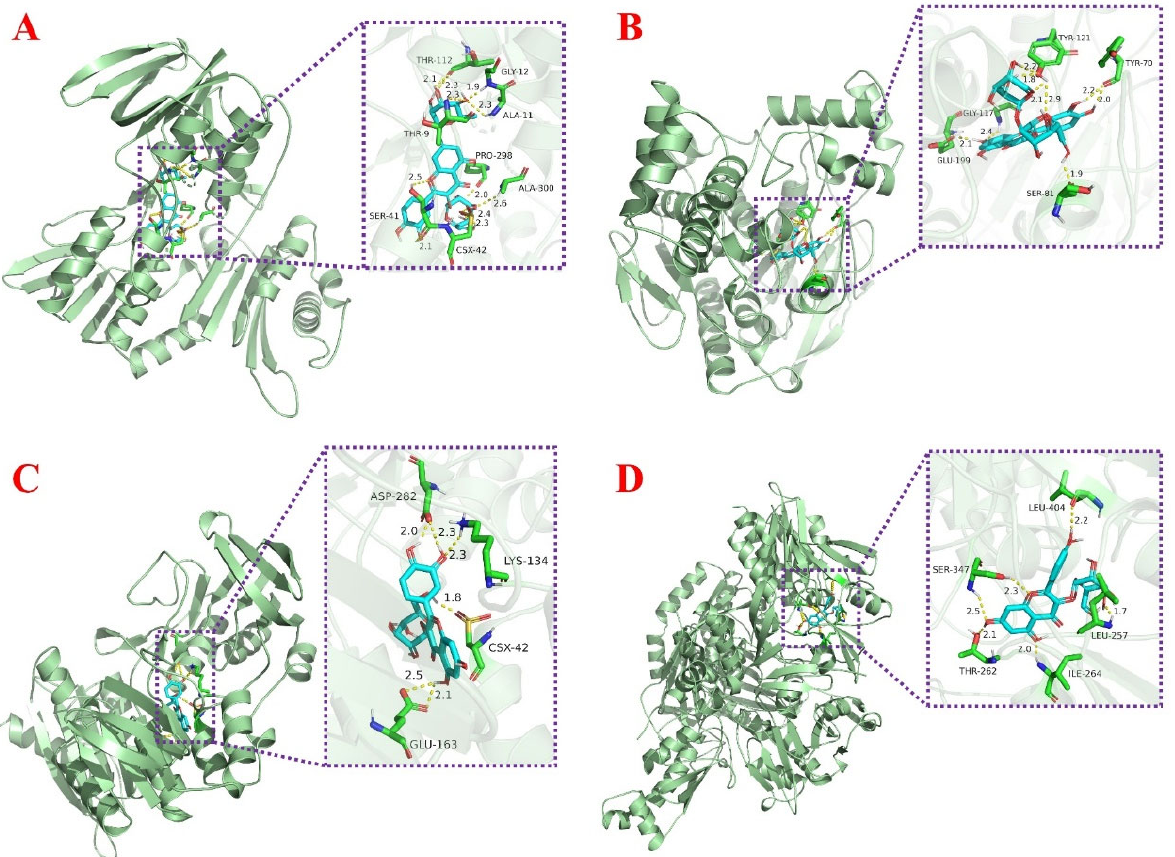
Figure 7. ( A ) Representation of molecular interaction between NADPH ‐ oxidase and Fr3 ‐ 1 ‐ 1 based on molecular docking. ( B ) Representation of molecular interaction between AChE and Fr3 ‐ 1 ‐ 2 based on molecular docking. ( C ) Representation of molecular interaction between NADPH ‐ oxidase and Fr3 ‐ 1 ‐ 3 based on molecular docking. ( D ) Representation of molecular interaction between XOD and Fr3 ‐ 1 ‐ 4 based on molecular docking.